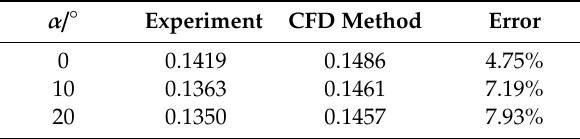
Table 1. Comparison of the propeller thrust coe ffi cient between the experiment and CFD